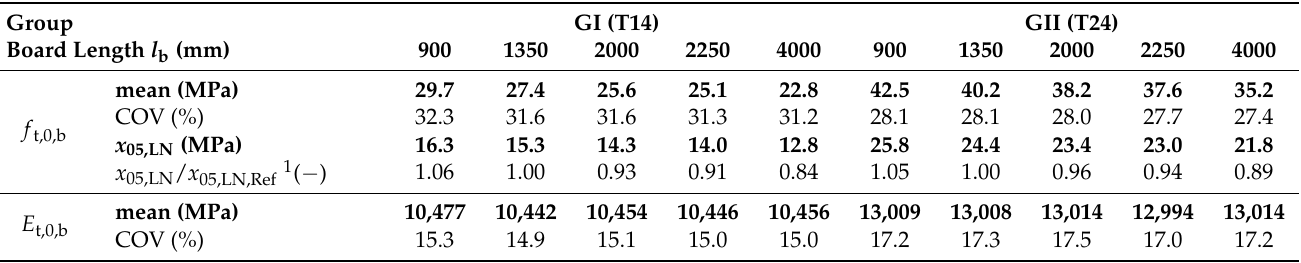
Table 8. Main statistics of the tensile strength f t,0,b and modulus of elasticity in tension E t,0,b parallel to the grain in (MPa) calculated from 1.5 × 10 4 simulated boards for each length and group, featuring a width of w b = 150 mm according to EN 338